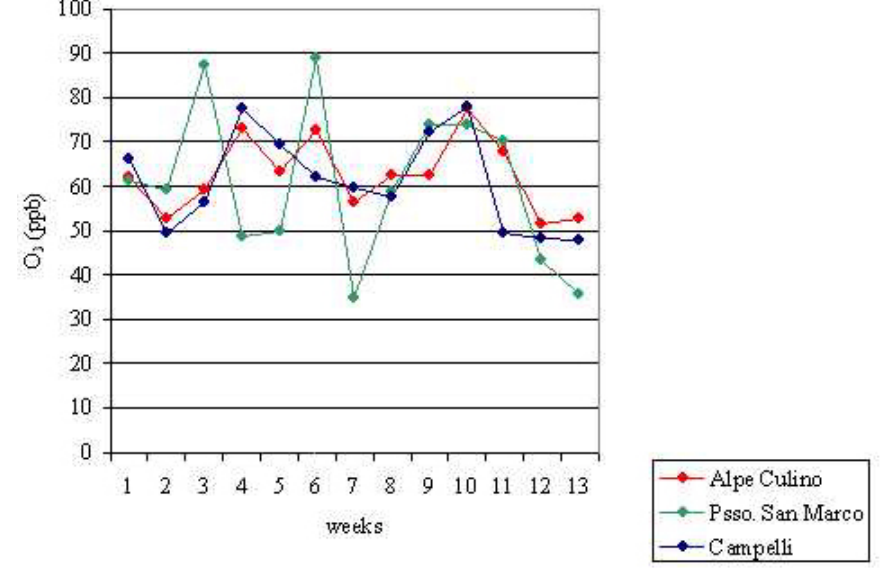
FIGURE 3. Ozone weekly concentrations trend in elevated sites